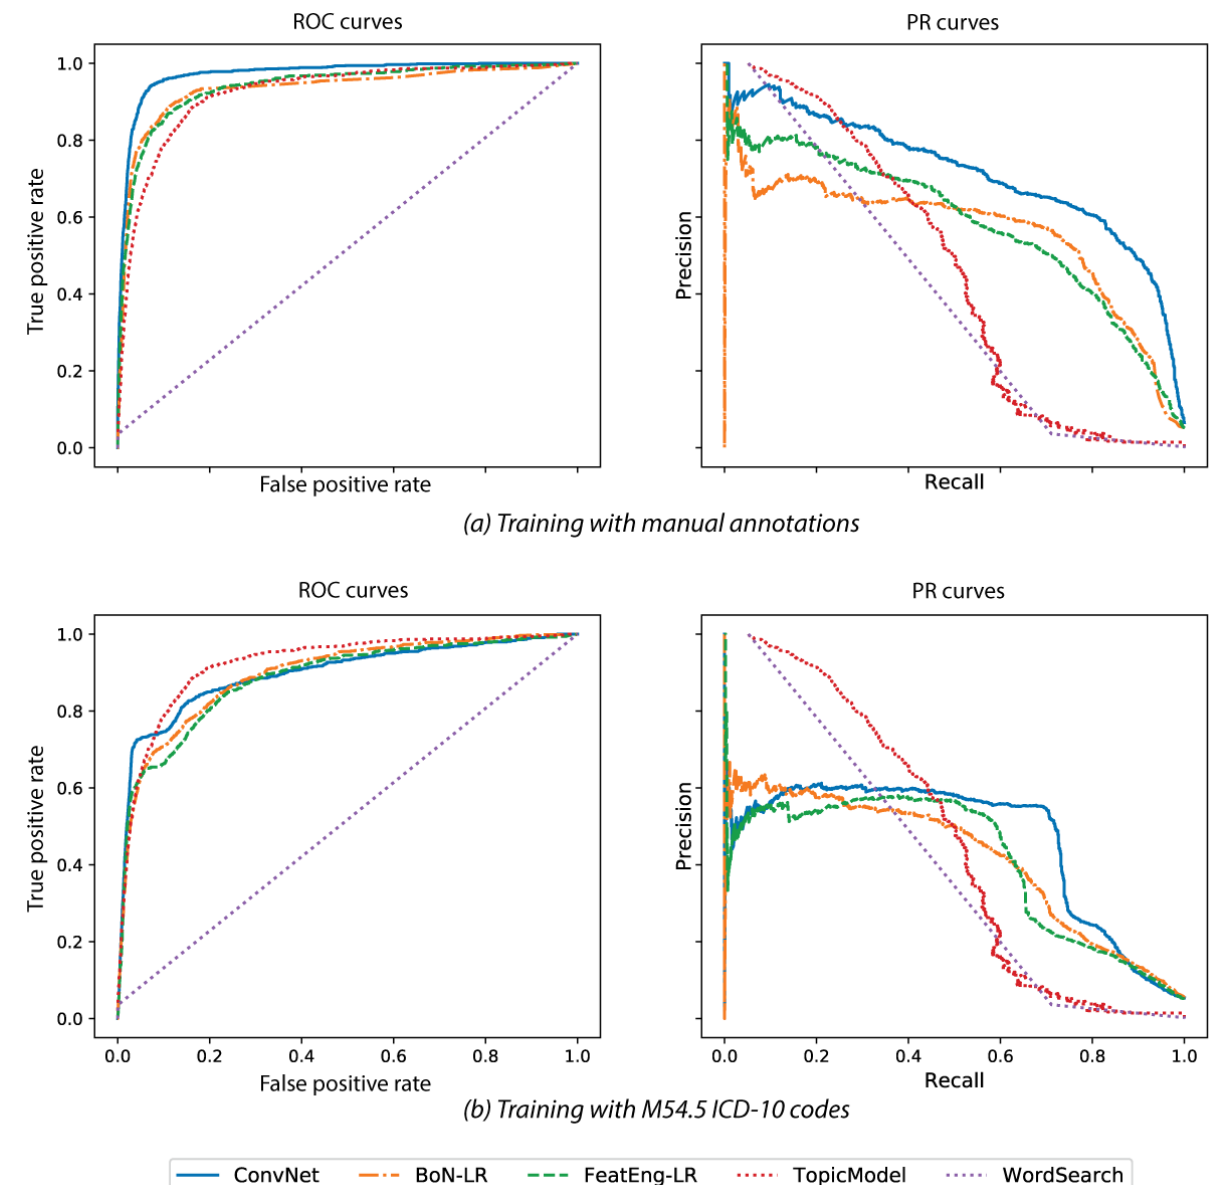
Figure 2. Receiver operating characteristic and precision-recall curves obtained when using as training data for BoN-LR, FeatEng-LR and ConvNet the manual annotations (a) and the M54.5 ICD-10 codes (b). ConvNet trained using the manual annotations obtained the best results. In the absence of manual annotations to use for training, TopicModel worked better than methods trained using ICD-10 codes, which proved not to be a good indicator to identify acuity in low back pain episodes. BoN-LR: logistic regression with bag of n-grams; ConvNet: convolutional neural network-based architecture; FeatEng-LR: logistic regression with feature engineering; ICD-10: international classification of diseases, 10th revision; PR: precision-recall; ROC: receiver operating